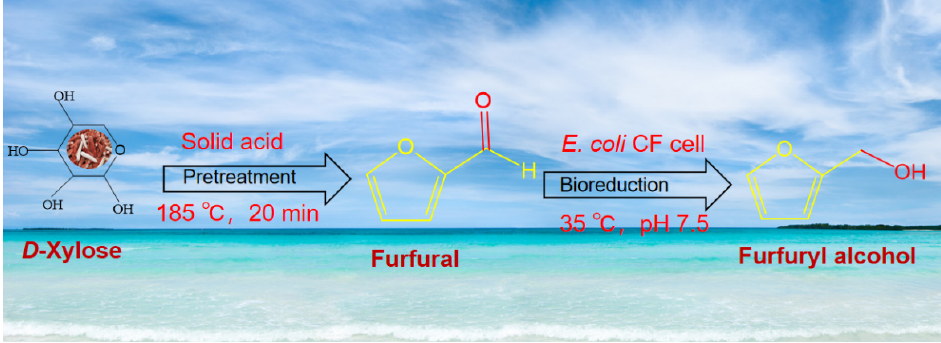
Figure 6. Tandem catalysis for chemoenzymatically valorizing D -xylose to FOL.